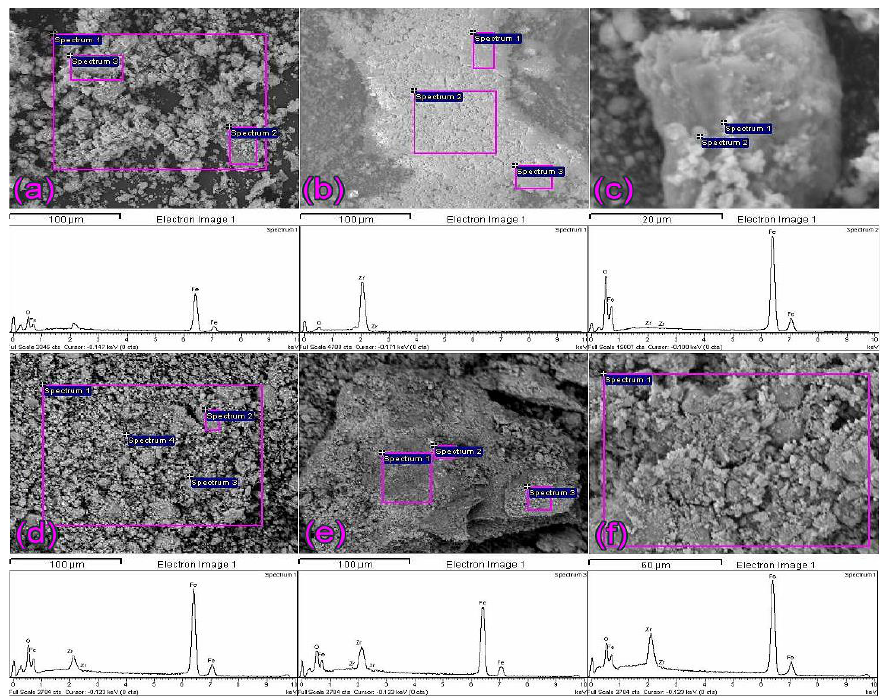
Figure 2. EDS spectra of particles: ( a ) Fe 3 O 4 and ( b ) ZrO 2 , as well as synthesized nanopowders: ( c ) 0.9ZrO 2 /Fe 3 O 4 ; ( d ) 3.5ZrO 2 /Fe 3 O 4 ; ( e ) 12ZrO 2 /Fe 3 O 4 and ( f ) 19ZrO 2 /Fe 3 O 4 , with corresponding area shown in SEM images.